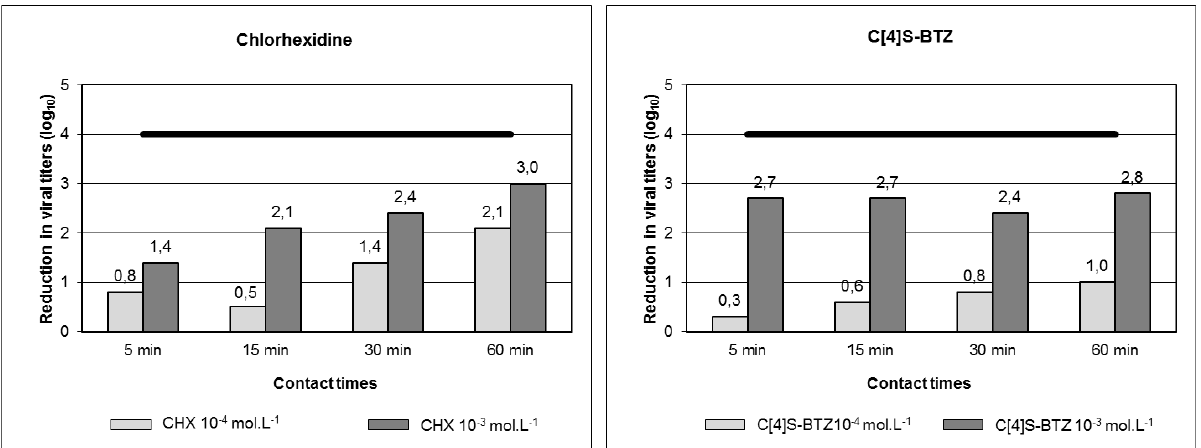
Figure 1. Evaluation of antiseptic HCoV 229E activity of (a) chlorhexidine (CHX) and (b) the 1,3-bis(bithiazolyl)-tetra-para-sulfonato-calix[4]arene (C[4]S-BTZ) [130,131]. The bold line in both graphs represents the European threshold of 4 log antiviral antiseptic